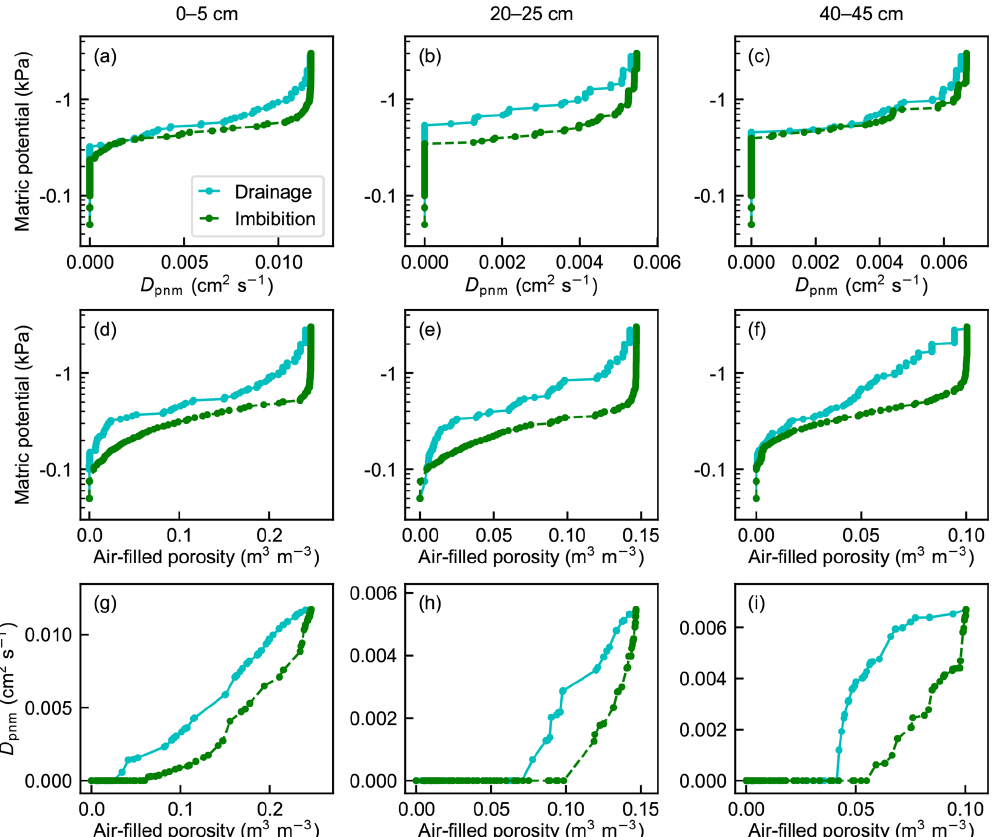
Figure 2. Simulation results for selected peat samples from (a, d, g) 0–5cm, (b, e, h) 20–25 cm, and (c, f, i) 40–45 cm depths: (a–c) soil gas diffusion coefficient and (d–f) air-filled porosity as a function of matric potential and (g–i) soil gas diffusion coefficient as a function of air-filled porosity.